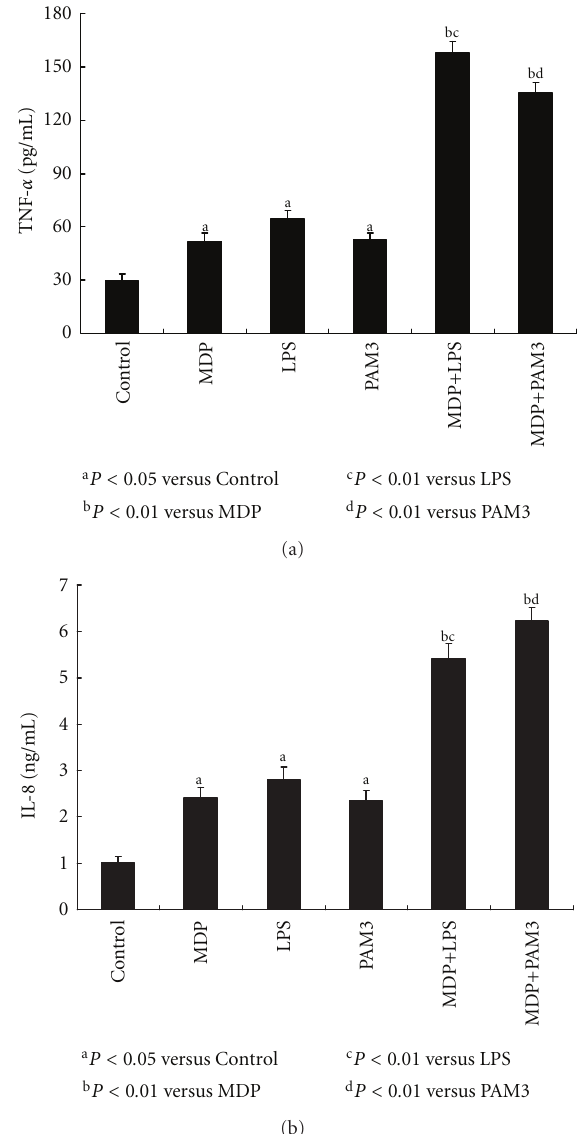
Figure 4: Inflammatory factors production by VSMC in response to MDP alone or in synergy with LPS and PAM3. VSMC have been stimulated by MDP, LPS, and PAM3 alone or in combination for 24h. IL-8 and TNF- α concentration in cell culture supernatant were measured by ELISA. (a) concentration of TNF- α in supernatant. MDP, LPS, or PAM3 alone can stimulate TNF- α secretion (MDP: 51.9 ± 4.73 pg/mL; LPS: 64.7 ± 4.21 pg/mL; PAM3: 52.7 ± 3.58 pg/mL; control: 29.4 ± 3.73 pg/mL; a P < 0 . 05 versus control, n = 3). The combination of MDP with LPS or PAM3 had stronger stimulation e ff ect. (MDP + LPS: 157.6 ± 6.68; MDP + PAM3: 135.6 ± 5.34; b P < 0 . 01 versus MDP; c P < 0 . 01 versus LPS; d P < 0 . 01 versus PAM3; n = 3). (b) concentration of IL-8 in supernatant. MDP, LPS, PAM3 alone can stimulate IL-8 secretion (MDP: 2.41 ± 0.22ng/mL; LPS: 2.82 ± 0.26 ng/mL; PAM3: 2.36 ± 0.21 ng/mL; control: 1.02 ± 0.13ng/mL; a P < 0 . 05 versus control, n = 3). The combination of MDP with LPS or PAM3 had stronger stimulation e ff ect. (MDP + LPS: 5.41 ± 0.32ng/mL; MDP + PAM3: 6.23 ± 0.28 ng/mL; b P < 0 . 01 versus MDP; c P < 0 . 01 versus LPS; d P < 0 . 01 versus PAM3; n =